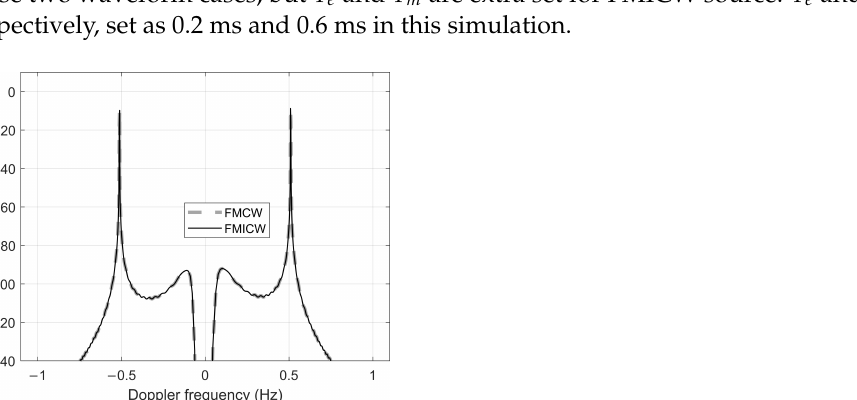
Figure 2. First-order cross section for FMCW and FMICW sources with a operating frequency of 25